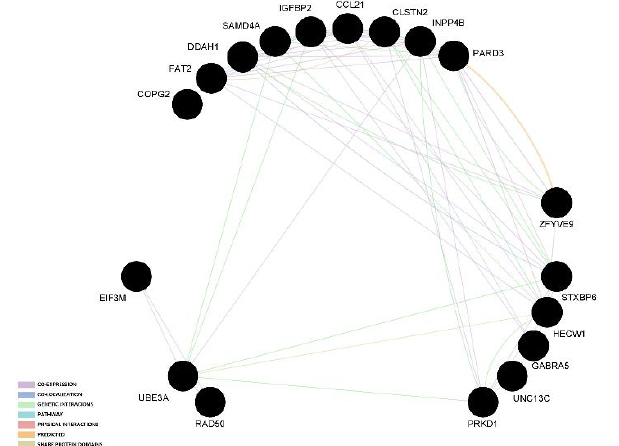
Figure 2. Gene network analysis of candidate genes that had an association reported with at least two reproduction traits or in two different populations.